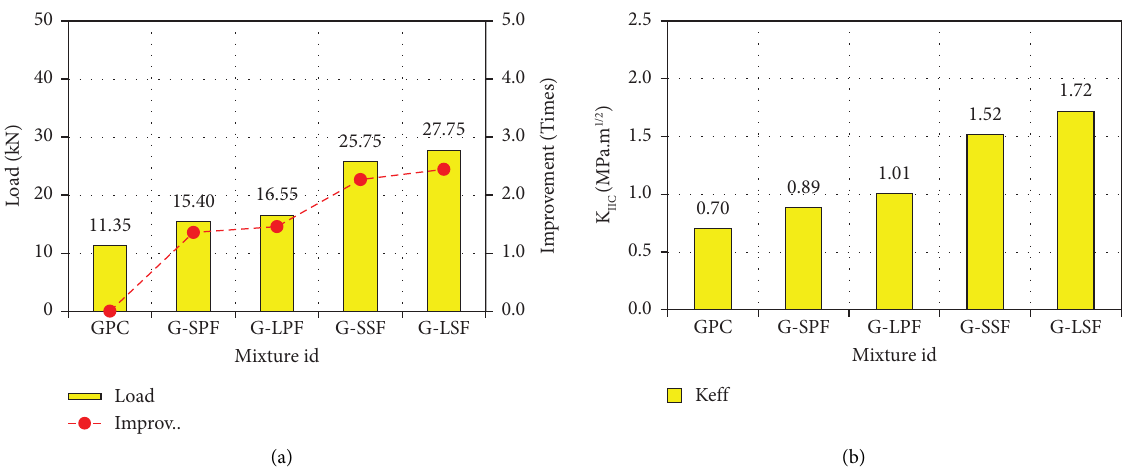
Figure 13: Mixed-mode fracture toughness of specimens under 60 °